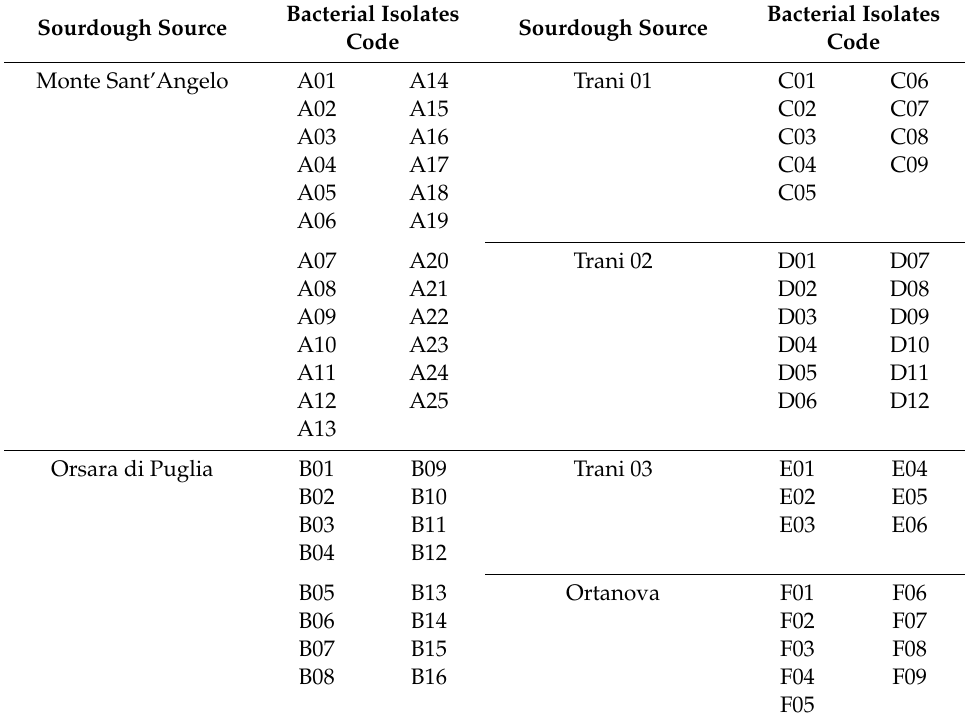
Table 2. Alphanumeric code of bacterial isolates screened in this